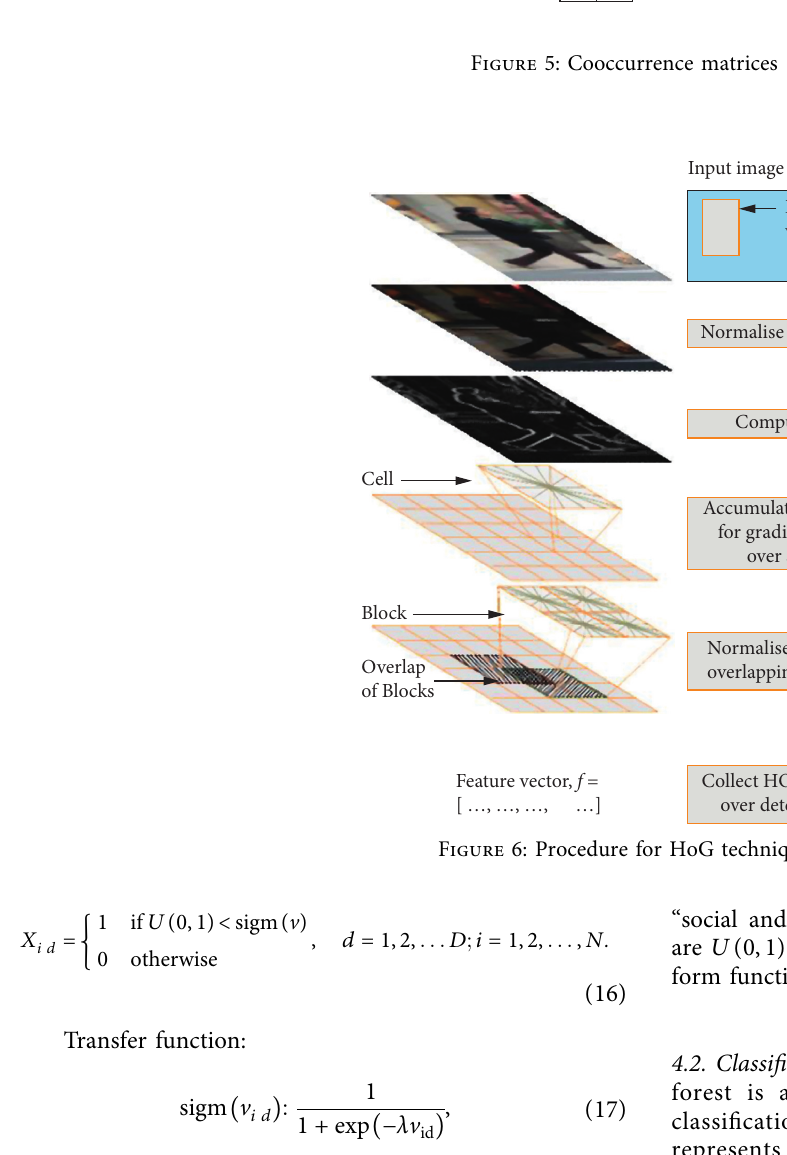
Figure 5: Cooccurrence matrices [35].